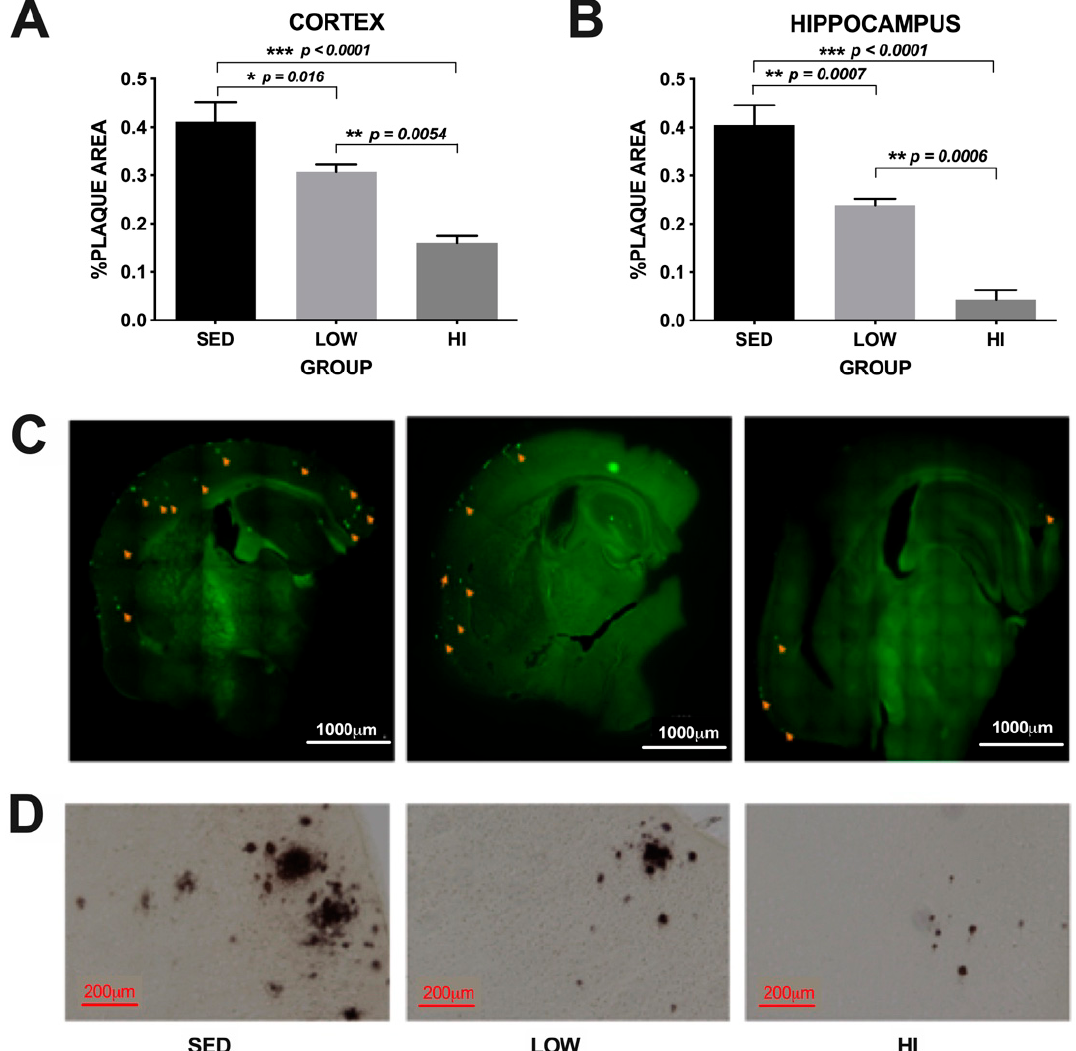
Figure 3. Amyloid plaque % area is decreased in an exercise training dose-dependent manner in both the cortex (Panel A ) and hippocampus (Panel B ) of Tg2576 mice following 12 months of treadmill running. Values represent the mean ± s.e.m. Panel C shows a representative image of amyloid plaque detected by Thioflavin S staining at 10 × magnification. Panel D shows a representative image of amyloid plaque detected by DAB staining at 40 × magnification.